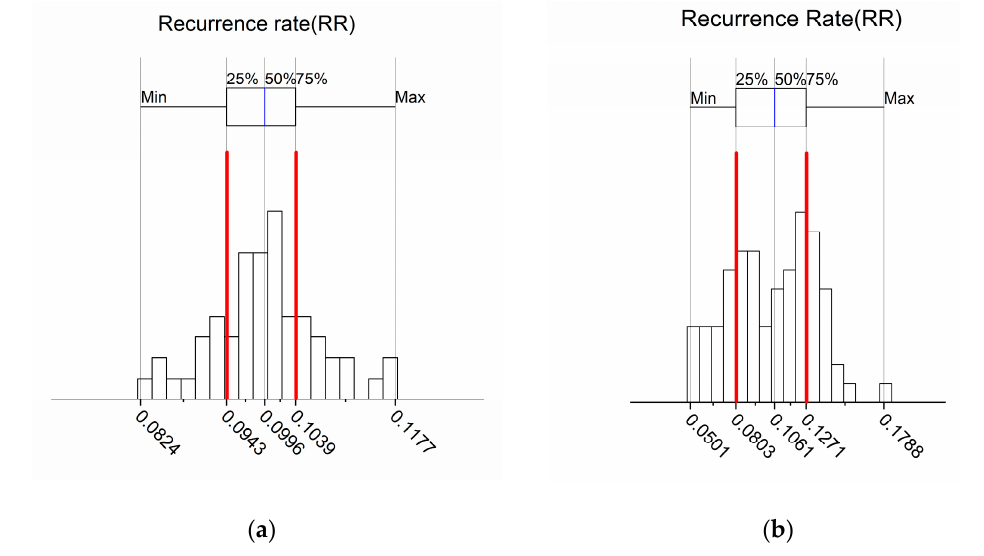
Figure 9. Box charts of recurrence rate (RR) of 100 Defect-free-1 signals: ( a ) the first half and ( b ) the second half.